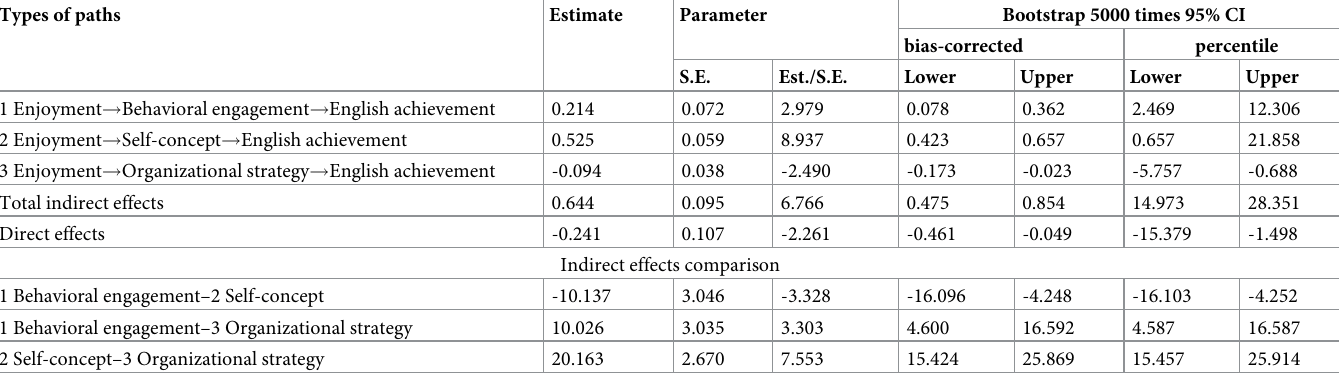
Table 2. Bootstrap-computed analyses of the mediation effects of behavioral engagement, self-concept, and organizational strategy in the relationship between aca- demic enjoyment and English achievement. Types of